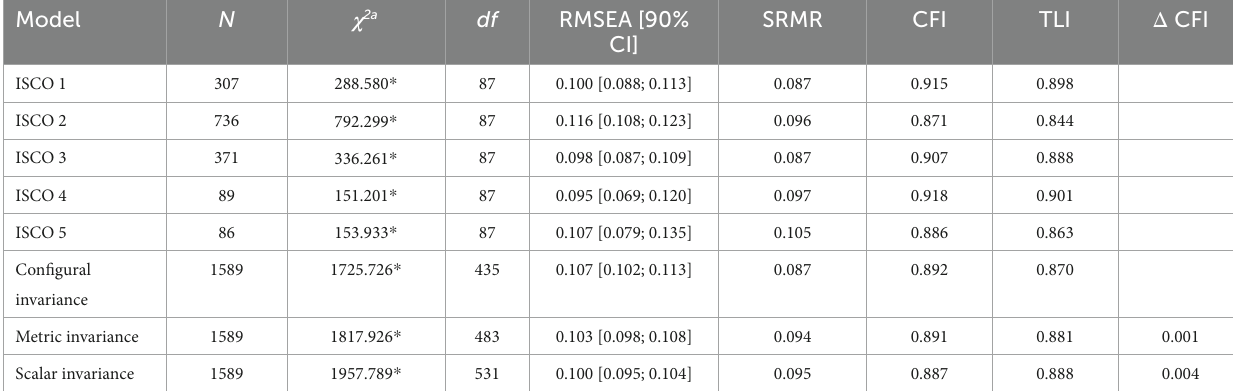
TABLE 5 Fit indices for single CFAs and measurement invariance models across occupations.